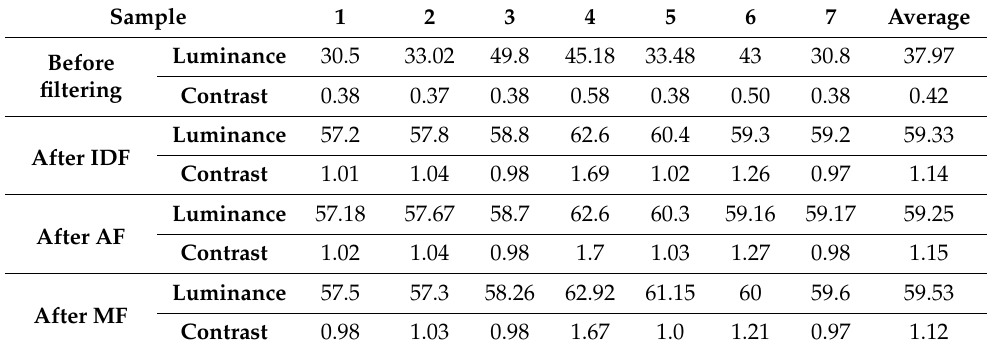
Table 2. Luminance and contrast of seven sample images before and after